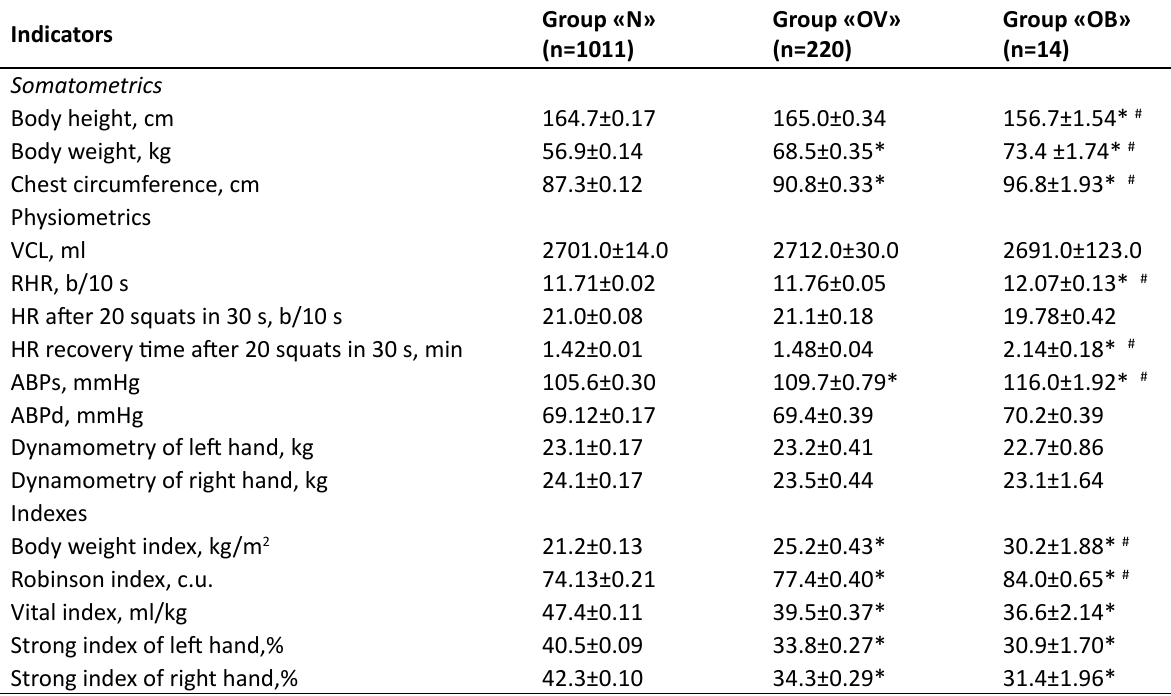
Table 1. The morphofunctional characteristics of females with different means of BMI (M±SD) Indicators